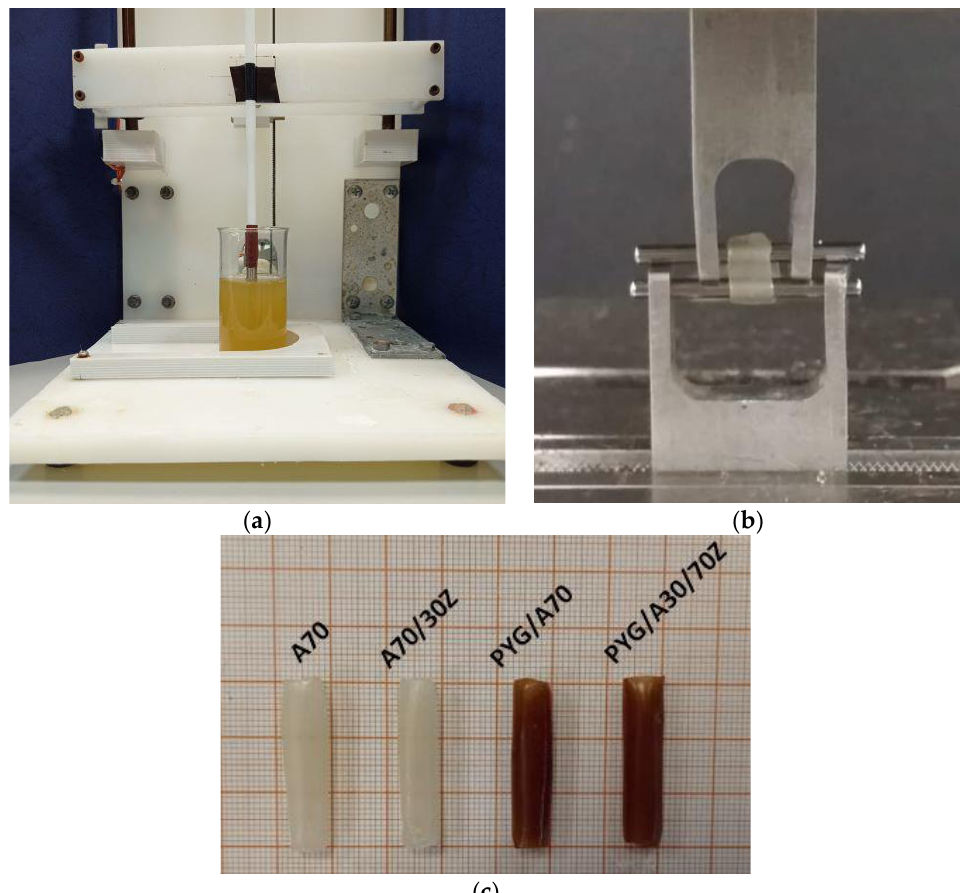
Figure 4. ( a ) Stand for forming hydrogel tubes based on sodium alginate by dip-coating, ( b ) testing the mechanical properties of hydrogel tubes in an axial tensile test, and ( c ) samples in the form of hydrogel tubes obtained by immersion method — examples.